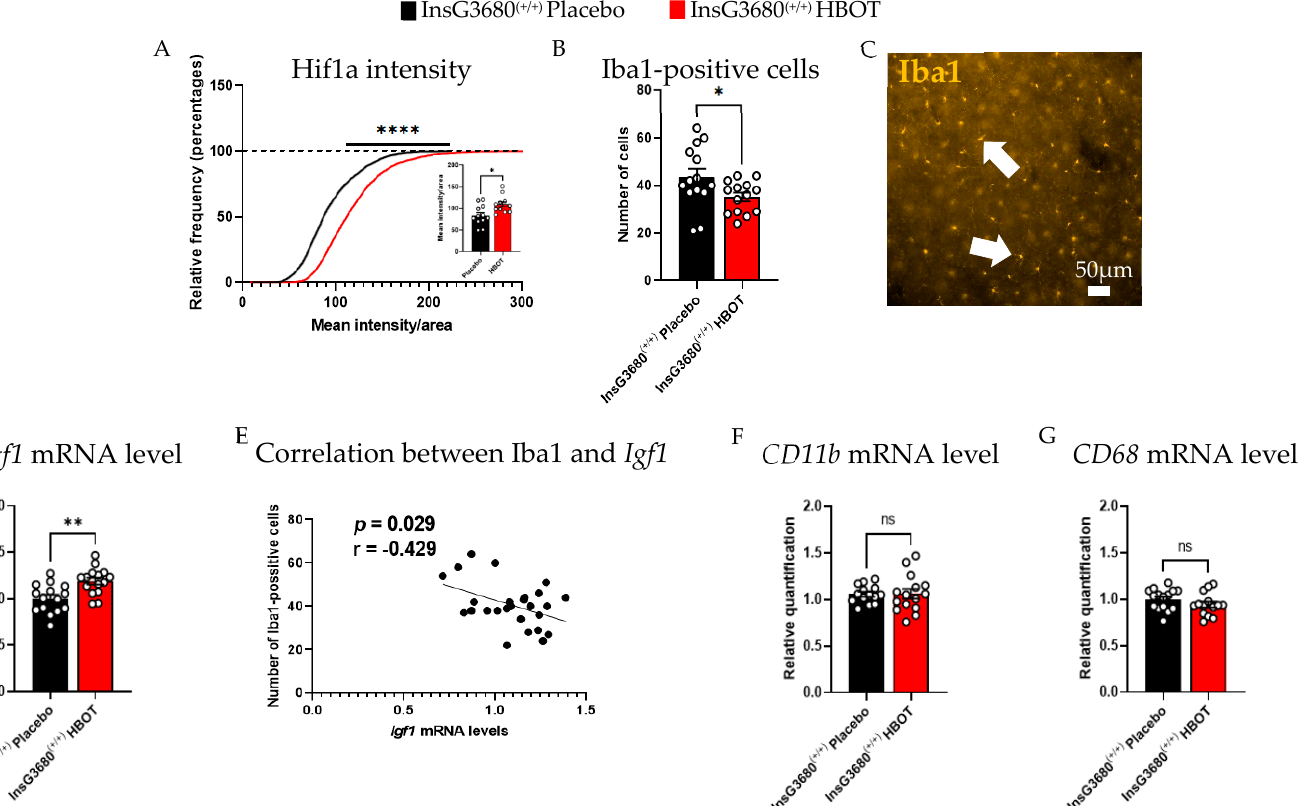
Figure 3. HBOT ameliorates neuroinflammation in P120 mice examined by molecular and cellular properties. ( A ) Cumulative distribution of the intensity of Hif1a divided by the area of the cell. Hif1a is significantly increased in the InsG3680 (+/+) HBOT group relative to the InsG3680 (+/+) placebo group (average intensity is divided by the averaged cell area). ( B ) The number of Iba1-positive cells is lower in the motor cortex of the InsG3680 (+/+) HBOT group compared to the InsG3680 (+/+) placebo. ( C ) Representative image of marked Iba1-positive cells marked by immunofluorescence staining. White arrows point to Iba1-positive cells. ( D ) The mRNA expression level of Igf1 in the whole cortex of a 4-month-old is upregulated in the InsG3680 (+/+) HBOT group compared to InsG3680 (+/+) placebo. ( E ) A significant negative correlation between the number of Iba1-positive cells and Igf1 expression levels in both InsG3680 (+/+) HBOT and InsG3680 (+/+) placebo. No significant difference was found in the mRNA expression level of ( F ) CD11b and ( G ) CD68 in the whole cortex of 3 month-old InsG3680 (+/+) HBOT group compared to InsG3680 (+/+) placebo. ns—non significant, * p < 0.05, ** p < 0.01, **** p < 0.0001. Two-tailed t -test ( A , B , D , F , G ). Kolmogorov-Smirnov ( A ). Pearson’s correlation coefficient ( E ). Data are shown as mean ±